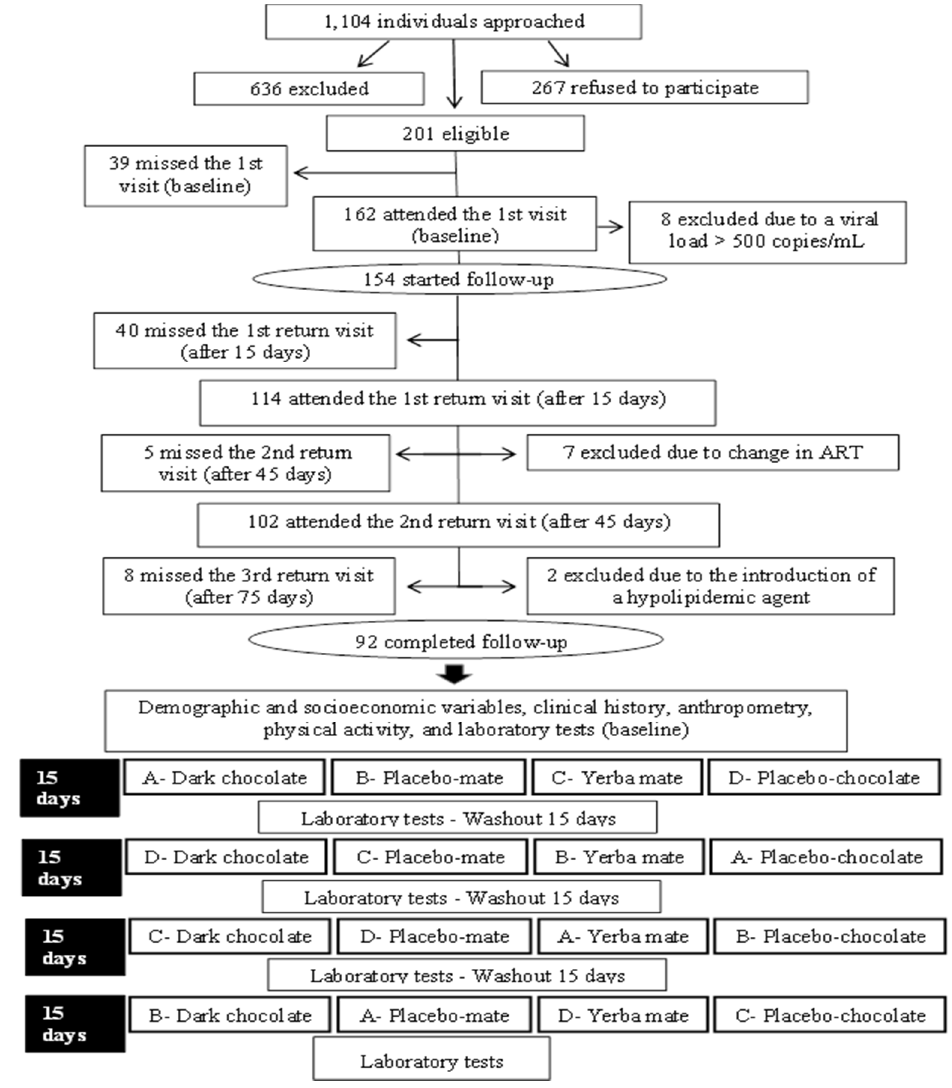
Figure 1. Flow diagram of the clinical trial.